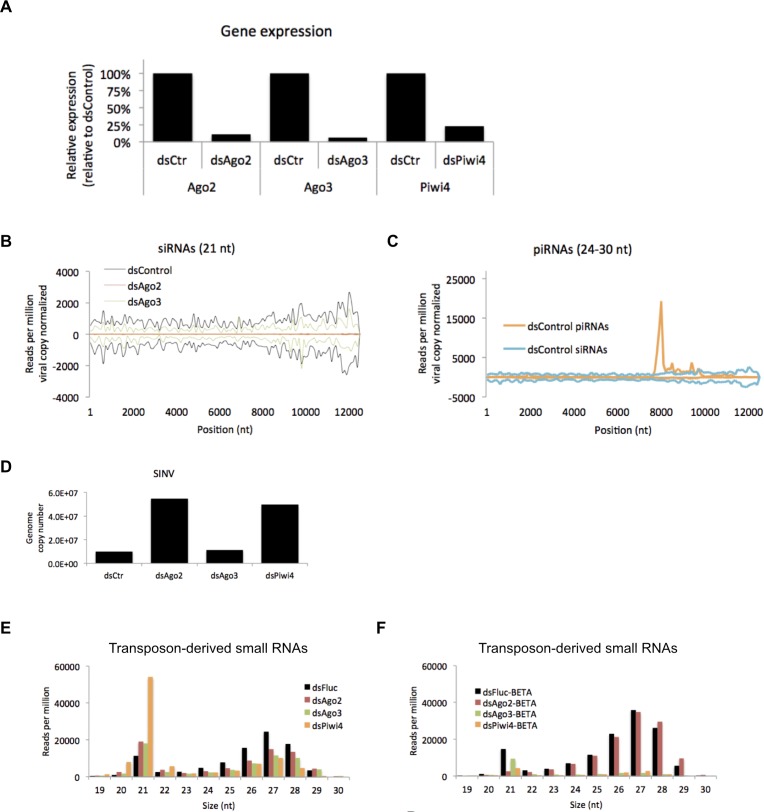
Effects of Ago2, Ago3 and Piwi4 knockdown on SINV-derived small RNAs.(A) Ago2, Ago3, and Piwi4 mRNA measured by RT-qPCR from large RNA fraction of sample used for small RNA library preparation. (B) Mapping of siRNAs (21 nt) to SINV genome from SINV infected Aag2 cells treated with control (dsFluc), Ago2, Ago3 or Piwi4[O1] dsRNA. (C) Mapping of piRNAs (24-30 nt) to SINV genome from SINV infected Aag2 cells treated with control (dsFluc), Ago2, Ago3 or Piwi4 dsRNA. The number of small RNAs is normalized to the number of SINV genome copies for each dsRNA treatment. (D) SINV genomic RNA measured by RT-qPCR from large RNA fraction of sample used for small RNA library preparation. (E) Size distribution plot of small RNA mapping to transposons from infected Aag2 cell treated with control, Ago2, Ago3, or Piwi4 dsRNA. (F) Size distribution plot of beta-elimination resistant small RNA mapping to transposon from infected Aag2 cells treated with control, Piwi4, or Ago3 dsRNA.